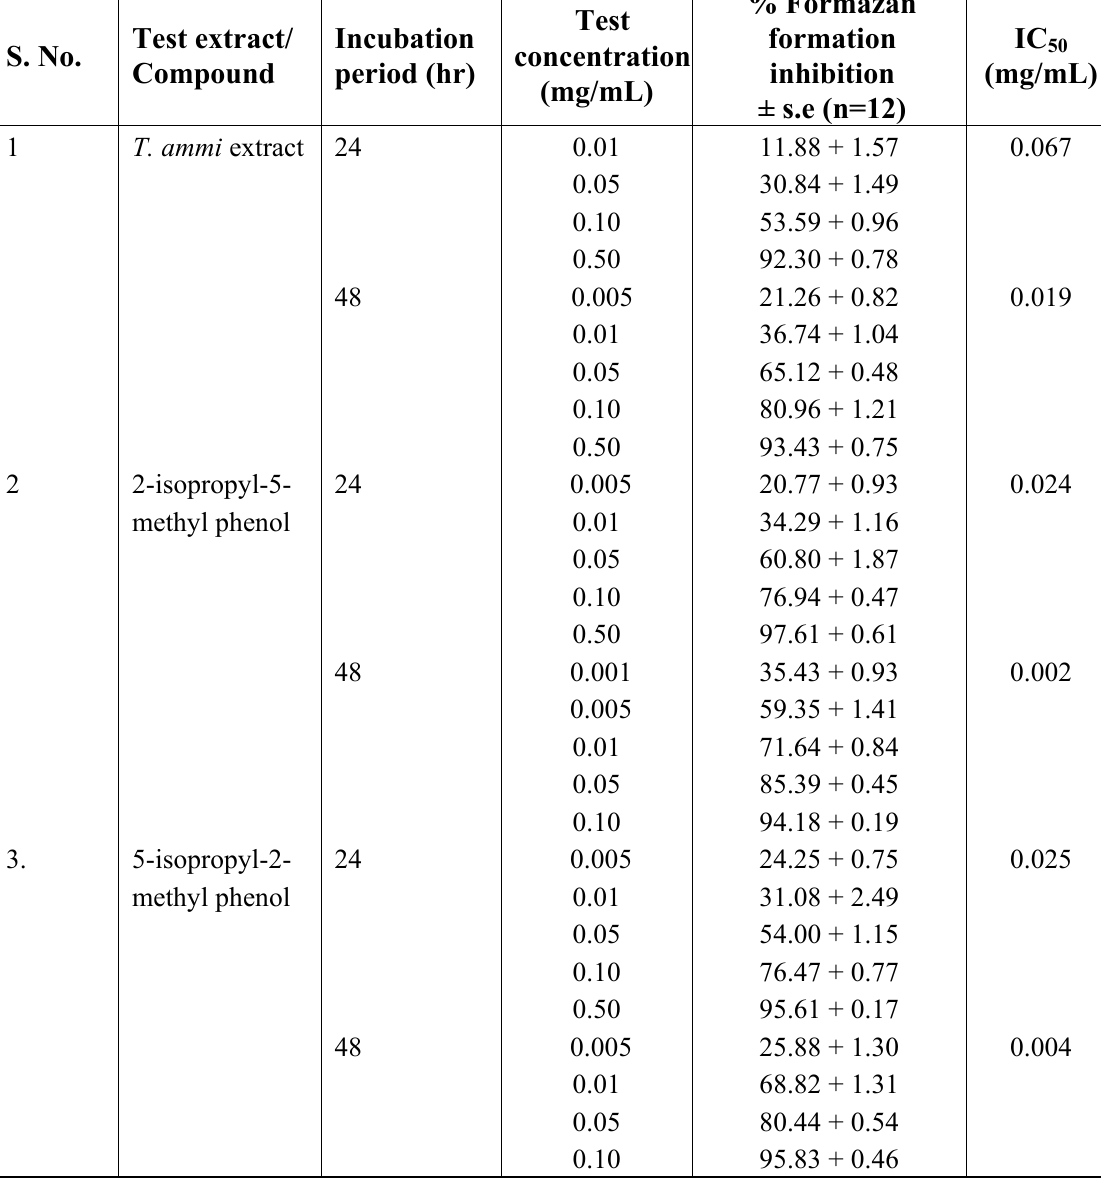
Table 1. In vitro macrofilaricidal activity of extract of T. ammi fruits against S. digitata adult females by the MTT reduction assay, in comparison with the active principle and its